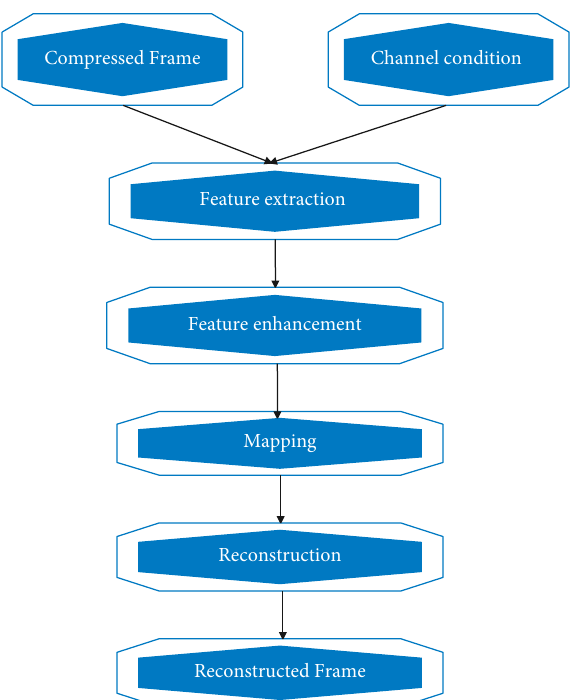
Figure 1: Convolutional neural network